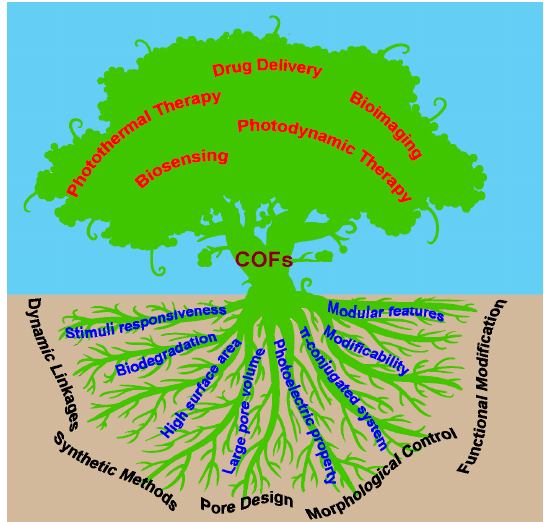
Figure 2. Schematic representation of the developments and properties of covalent organic frameworks (COFs) and their applications in biomedicine.